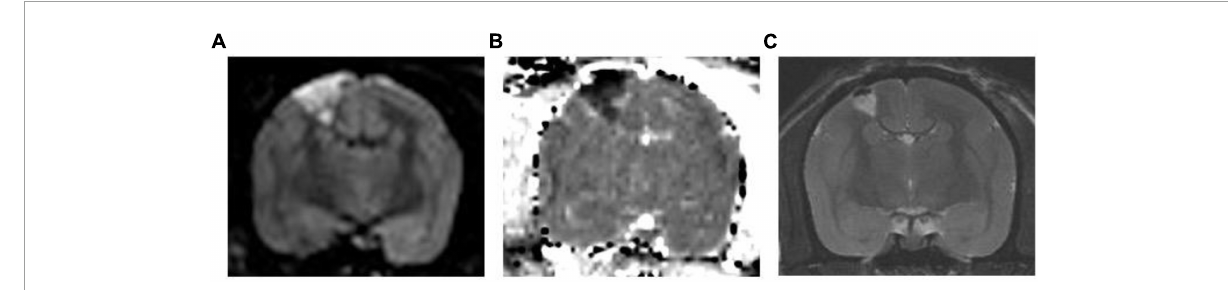
FIGURE3 Representative MR Images. (A) Diffusion-weighted image and (B) corresponding apparent diffusion coefficient map. The high-intensity area in the diffusion-weighted image shows low intensity in the apparent diffusion coefficient map, which suggests that this area is infarcted. (C) T2-weighted image 1 month after surgery. The infarcted area shows hyperintensity in the T2-weighted